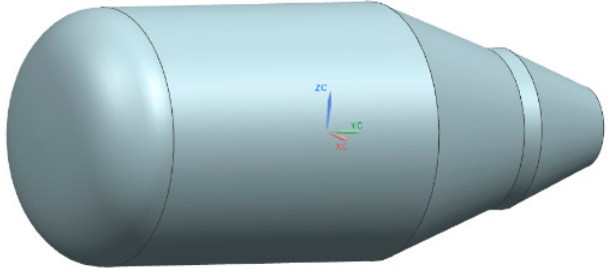
Figure 3. 3D drawing of 6 m 3 vessel fluid volume.